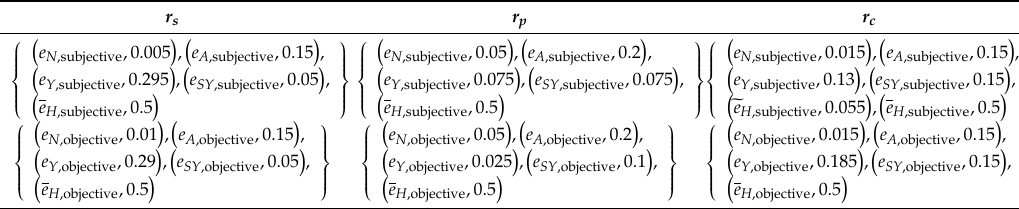
Table 6. Basic probability assignment (BPA).